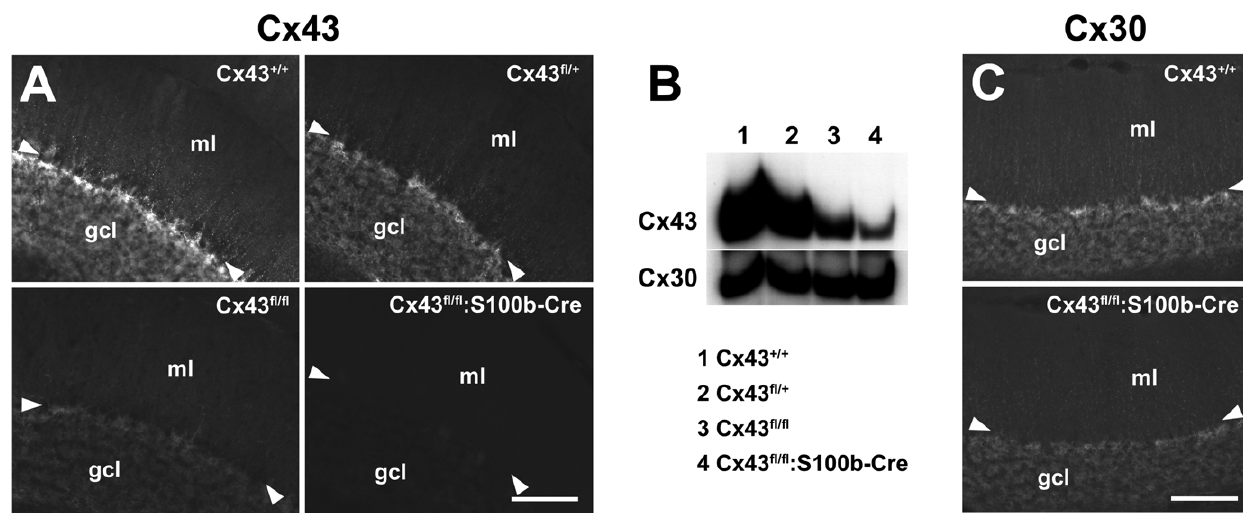
Figure 6. Extent of S100b-Cre -mediated loss of Cx43 and evaluation of compensatory Cx30 upregulation in Cx43 fl /fl :S100b-Cre mice. (A) Immunofl uorescence analysis of parasagittal sections of the cerebellum from Cx43 + / + (WT), Cx43 fl / + , Cx43 fl /fl , and Cx43 fl /fl :S100b-Cre mice (2.5 month old) using antibodies directed to Cx43. (B) Immunoblot analysis of cerebellar lysates from Cx43 + / + , Cx43 fl / + , Cx43 fl /fl , and Cx43 fl /fl :S100b-Cre mice (2.5–3 month old) using antibodies directed to Cx43 and Cx30. (C) Immunofl uorescence analysis on parasagittal sections of the cerebellum from Cx43 + / + , and Cx43 fl /fl :S100b-Cre mice (2.5 month old) using antibodies directed to Cx30. Arrowheads indicate Purkinje cell layer. gcl, granule cell layer; ml, molecular layer; wm, white matter. Scale bars, 100